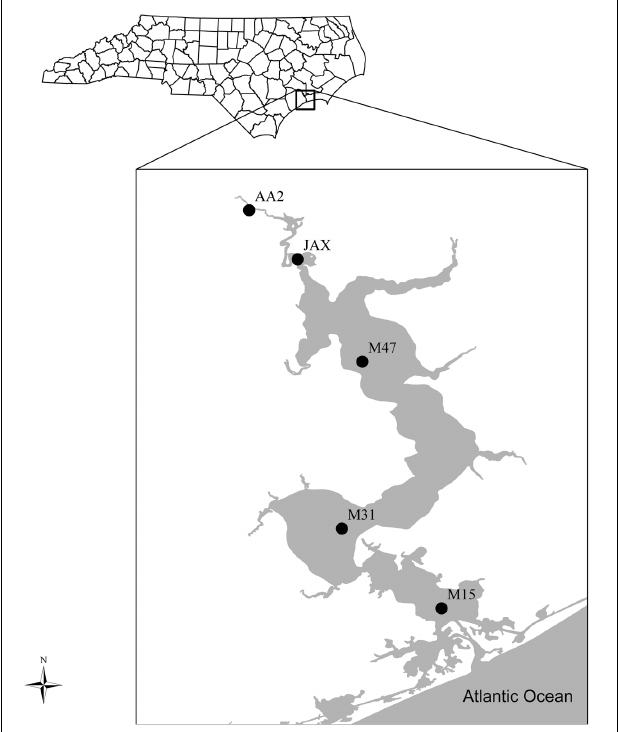
FIGURE 1 | Sampling Sites in the New River Estuary, NC, USA. Five sites include an upper estuary site (AA2), two mid-estuary sites (JAX and M47), and two lower estuary sites (M31 and M15).